Question: What does this figure show? Answer in one sentence.
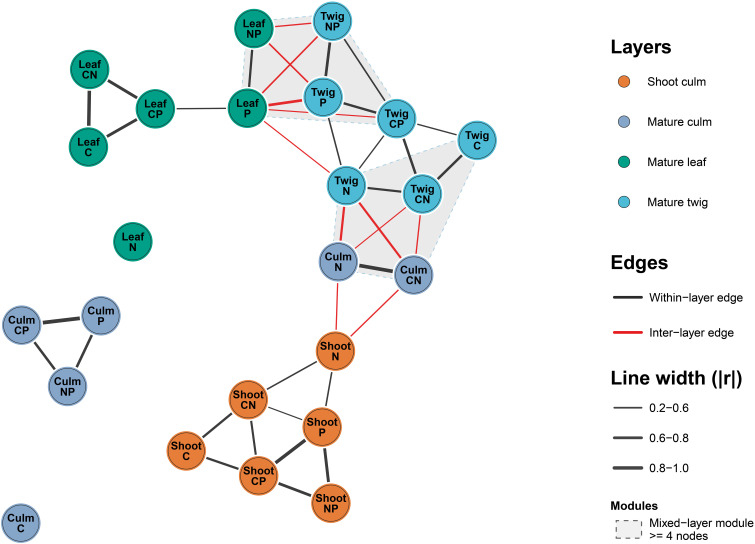
Answer: A multilayer network of Fargesia denudata stoichiometric traits. Onlycorrelations meeting the retained-edge criteria are shown (|r| > 0.2, FDR-adjusted p ≤ 0.05). In the network, Shoot refers to shoot culm, whereas Culm, Leaf, and Twig represent traits only at the mature stage. C, C concentration; N, N concentration; P, P concentration; CN, C:N ratio; CP, C:P ratio; NP, N:P ratio. The complete pairwise correlation table is provided in Supplementary Table 1 .